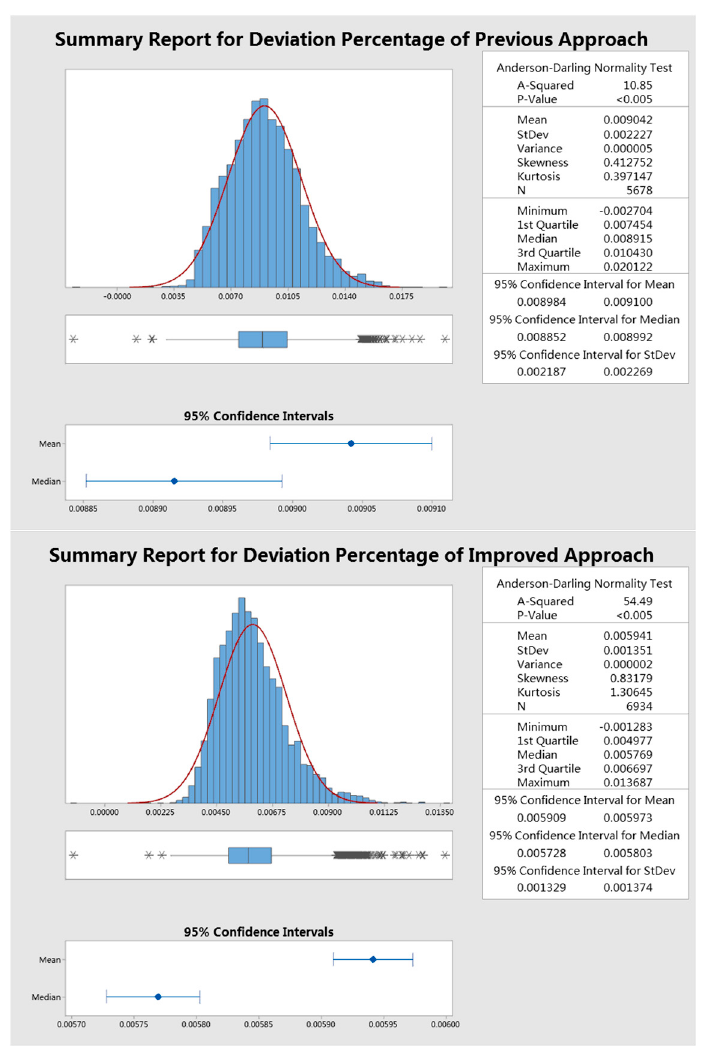
Figure A5. Deviation percentage distributions. Table A6. Cluster analysis of the new approach (Case B).